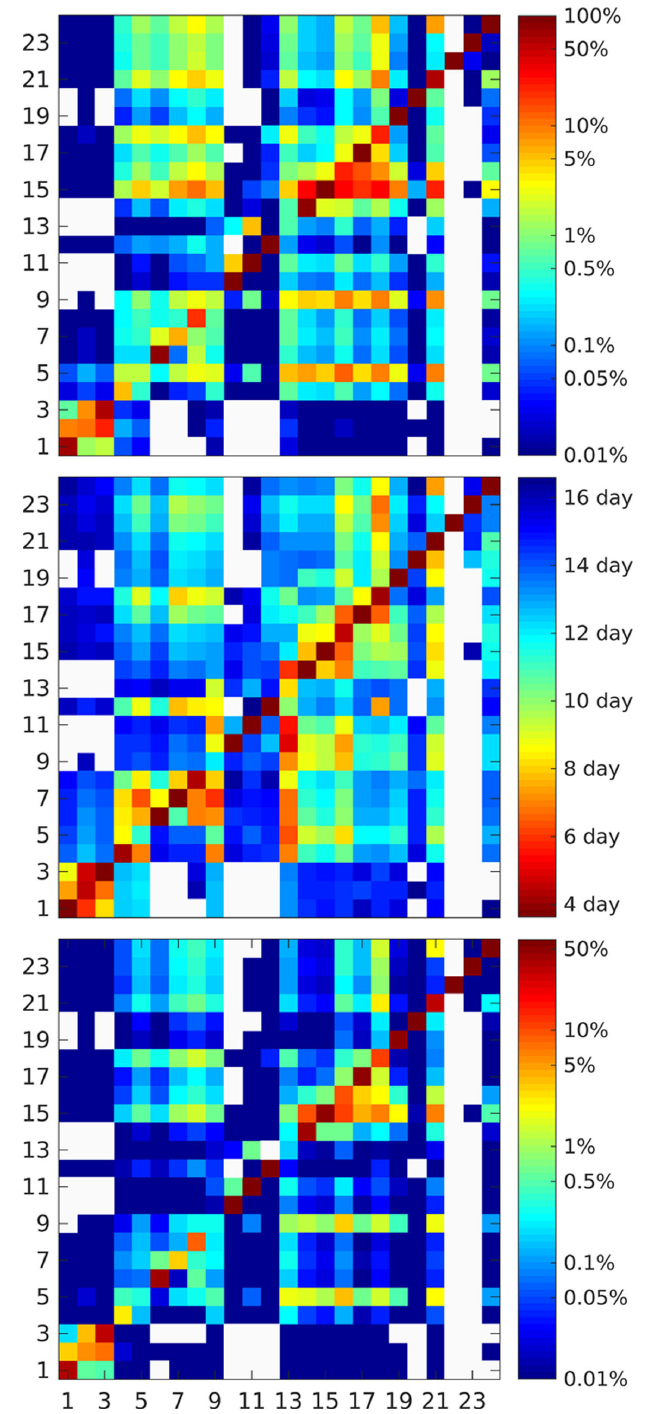
Fig. 7. (a) Percentage of unique infectious larvae released from one farm site entering any other farm site or its initial release site. (b) Mean age of the connections. (c) Connectiv- ity including mortality. Emitting farms are on the x -axis and receiving farms on the y -axis. The color bar indicates the percentage in (a) and (c), scale is logarithmic. The color bar in (b) indicates the mean age in days. White indicates no